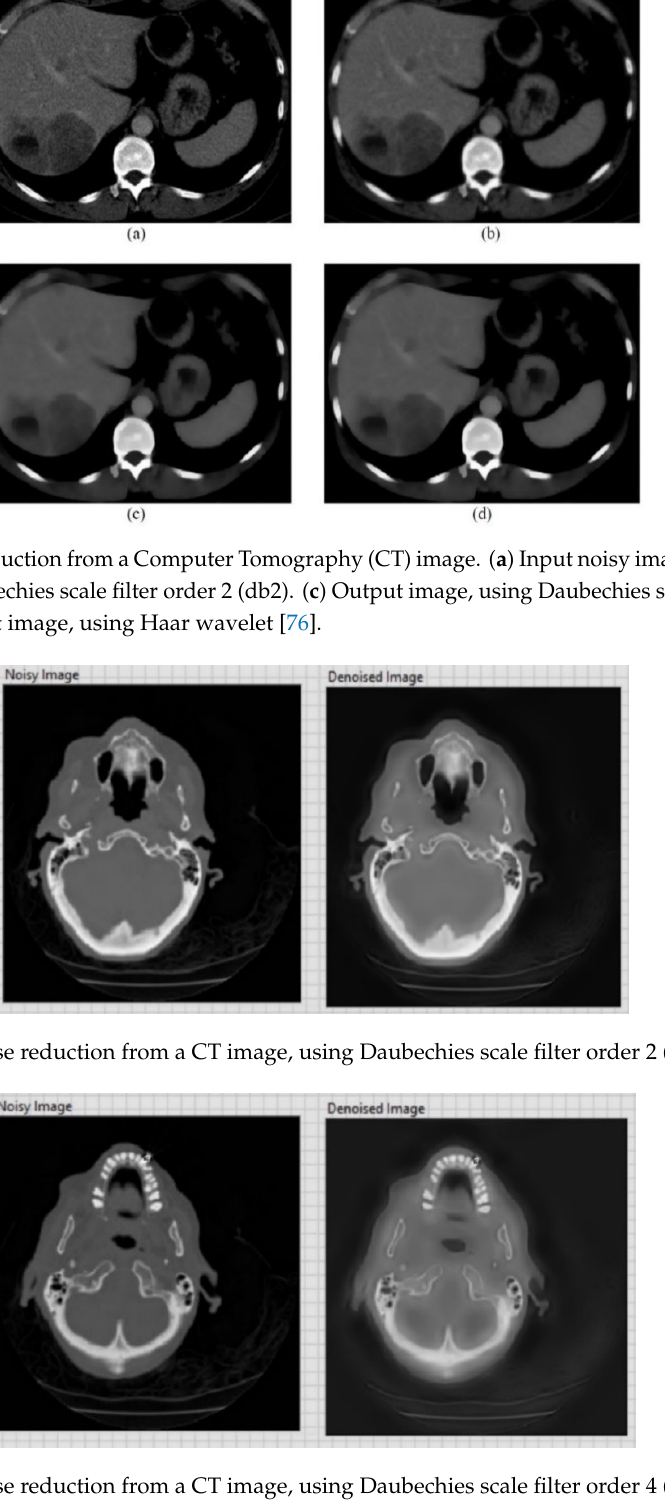
Figure 9. Noise reduction from a CT image, using Daubechies scale filter order 4 (db4) [76].